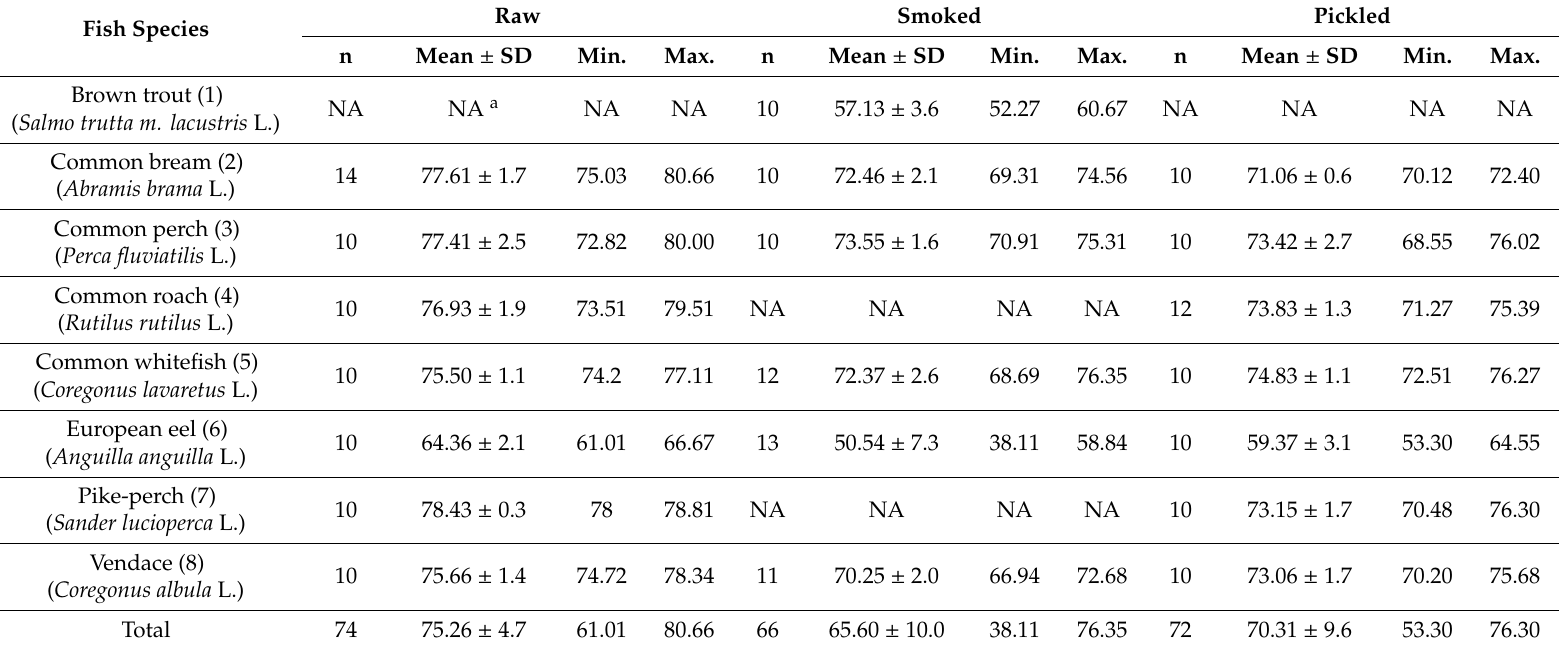
Table 5. Water content in raw, smoked and pickled fish product samples (g / 100 g). Raw Smoked Pickled Fish Species Min. Max. Min. Max. Mean ± SD Min.